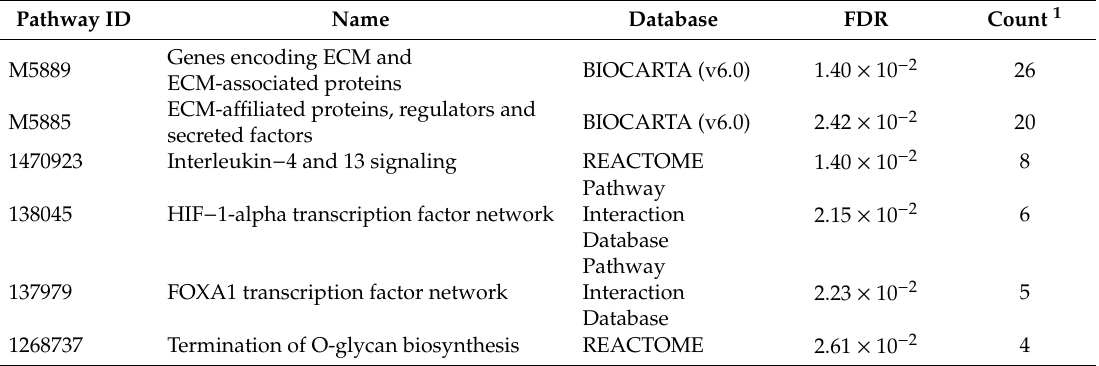
Table 6. The enriched pathways from BIOCARTA, REACTOME and Pathway Interaction